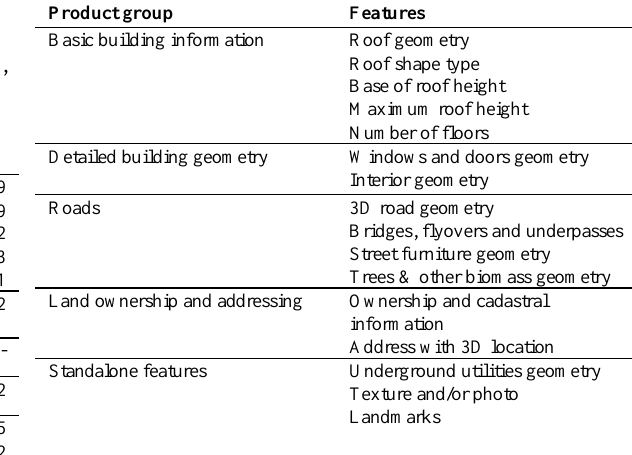
Table 3. Potential product groups and features derived from